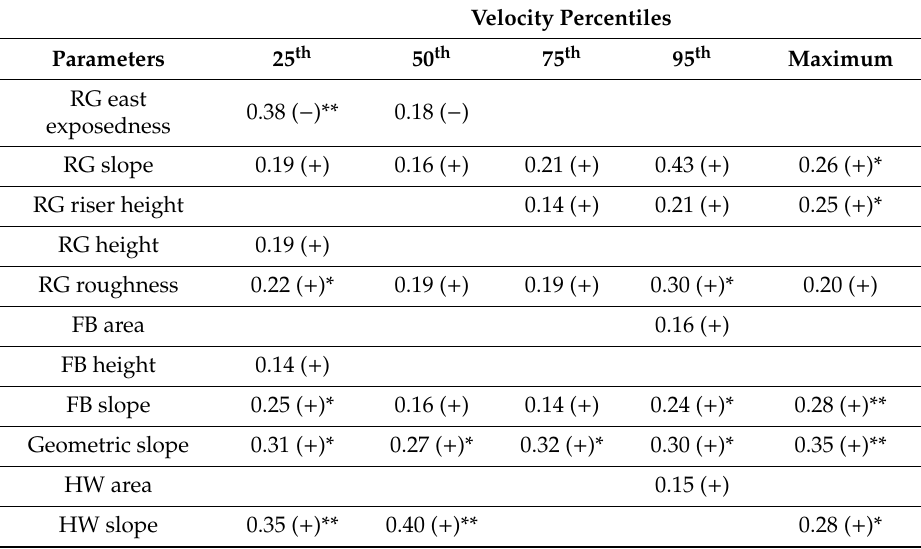
Table 3. R 2 -values for iteratively reweighted least squares (IRLS) regression on selected parameters for di ff erent percentiles of velocity distribution. Values are only given for slope coe ffi cients significantly di ff erent from zero ( p -value ≤ 0.05). The direction of correlation is indicated in